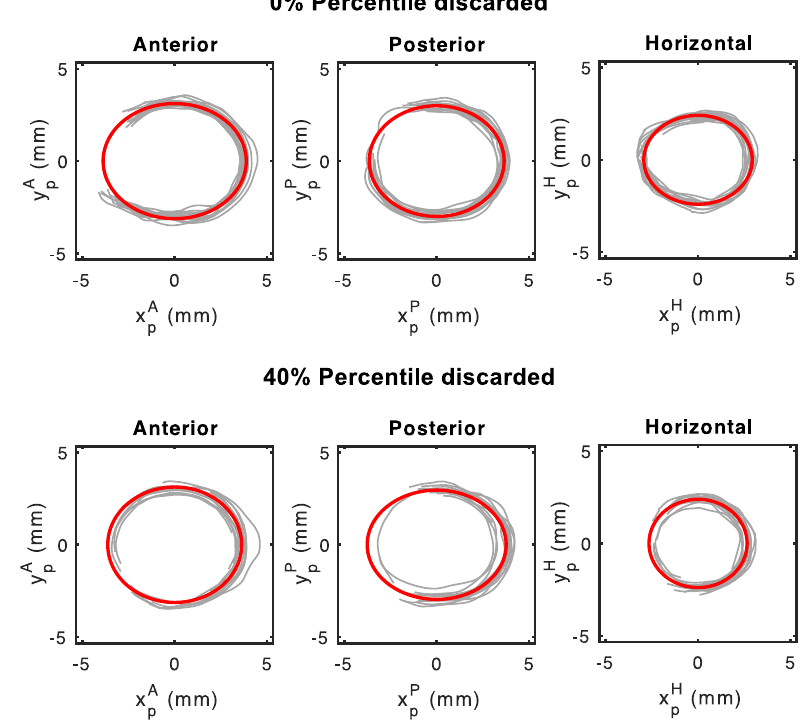
Figure 11. Centerlines projected on the respective reference planes for the A, P and H ducts: ( top ) the behavior for the whole ducts; and ( bottom ) when 40% is discarded. The red thick line correspond to the ellipse that best fits all the data from the different